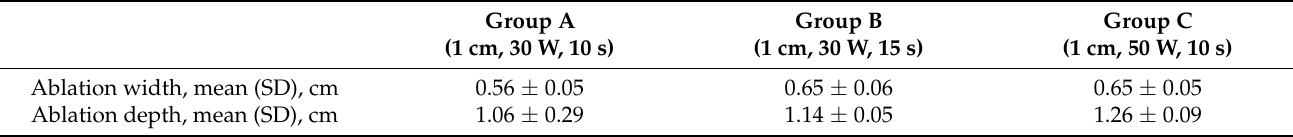
Table 2. Ablation effects based on the RFA power and ablation time.